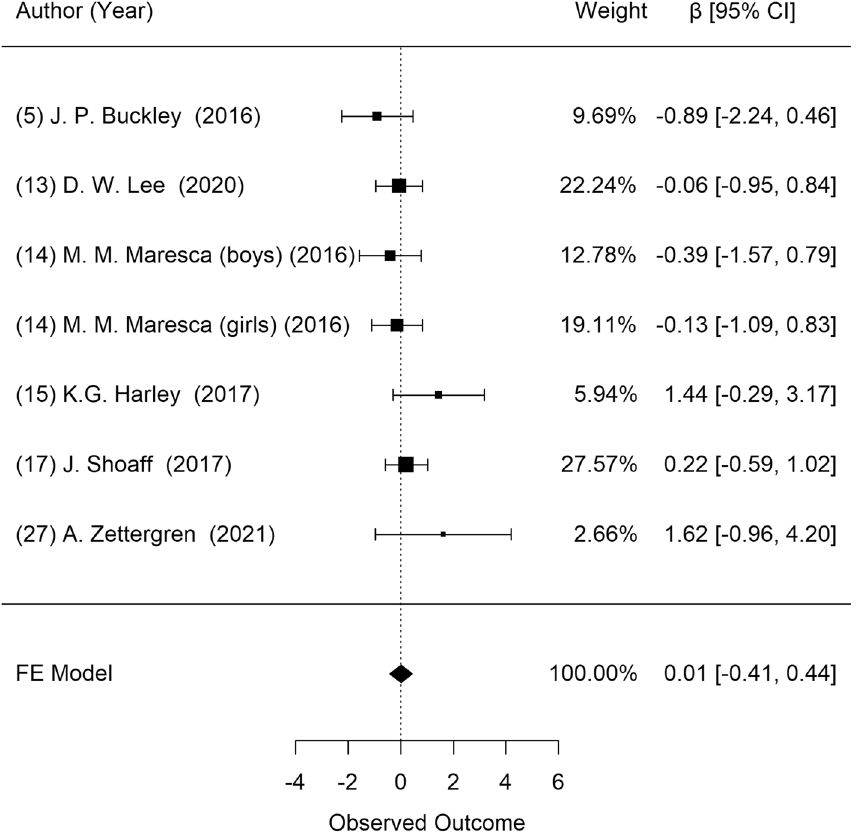
Figure 4. Forest plot of studies on the association of DEHP exposure with body fat percentage: longitudinal studies. Estimates were standardized as β and 95% confidence intervals as one unit increase of natural log of DEHP